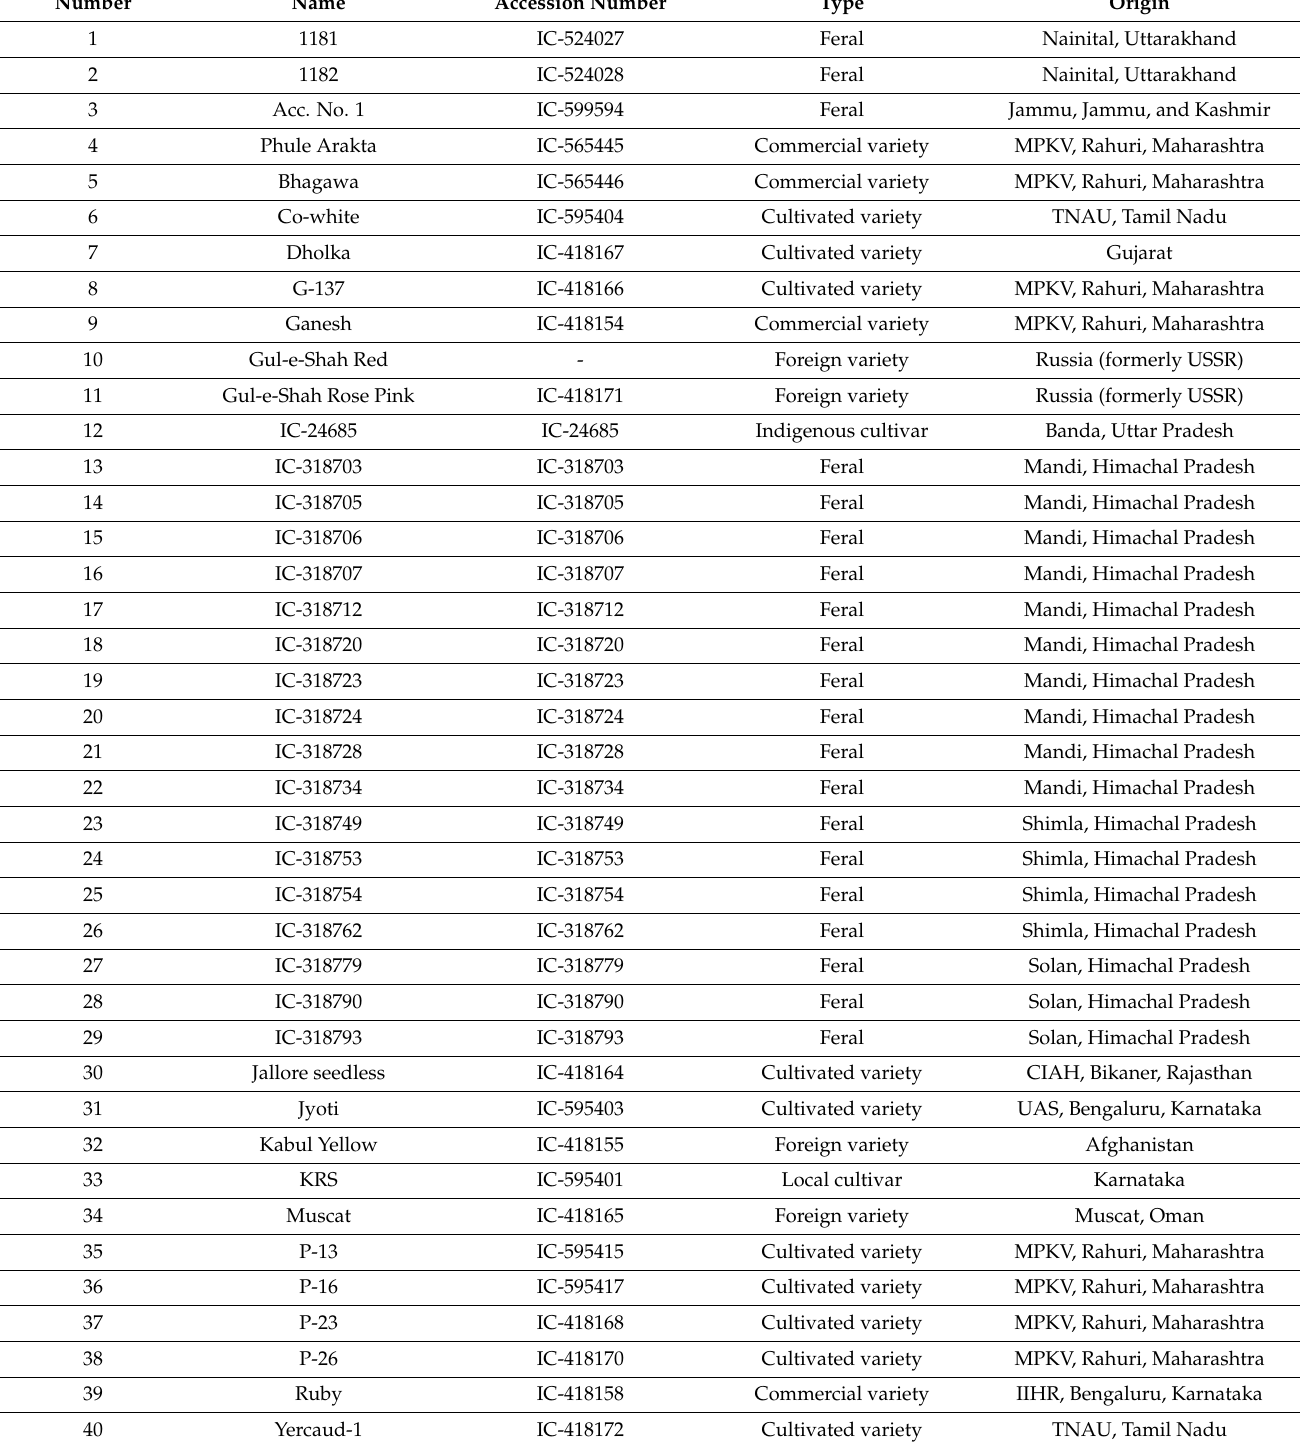
Table 6. Pomegranate accessions under